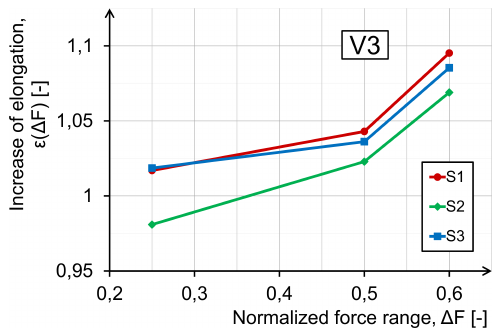
Figure 11: Increase of elongation ε ( ∆F ) evaluated from variable V3 loading history. Table 5: Increase of elongation ε ( ∆F ) for V3 loading history.